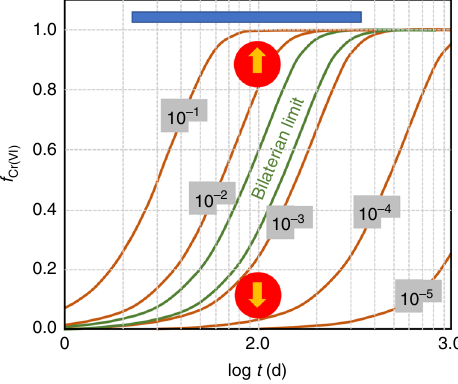
Fig. 7 Oxygen model results. Results are redrawn from ref. 8 including interpolated results for oxygen levels of 10 − 2 PAL and 10 − 4 PAL, not presented in the original fi gure. The x axis presents soil water residence time, and the blue bar on top represents the range in modern soils. The y axis represents the fraction of the original Cr(III) in the soil oxidized to Cr (VI) and the contours represent different levels of atmospheric oxygen in fraction of PAL. The lower-limit range of oxygen requirements for bilaterian animals with a simple circulatory system 64 is constrained between the green lines. The lower red circle represents the maximum atmospheric oxygen concentration as constrained by Planavsky et al. 8 , whereas the upper red circle represents the minimum atmospheric oxygen estimate of the present